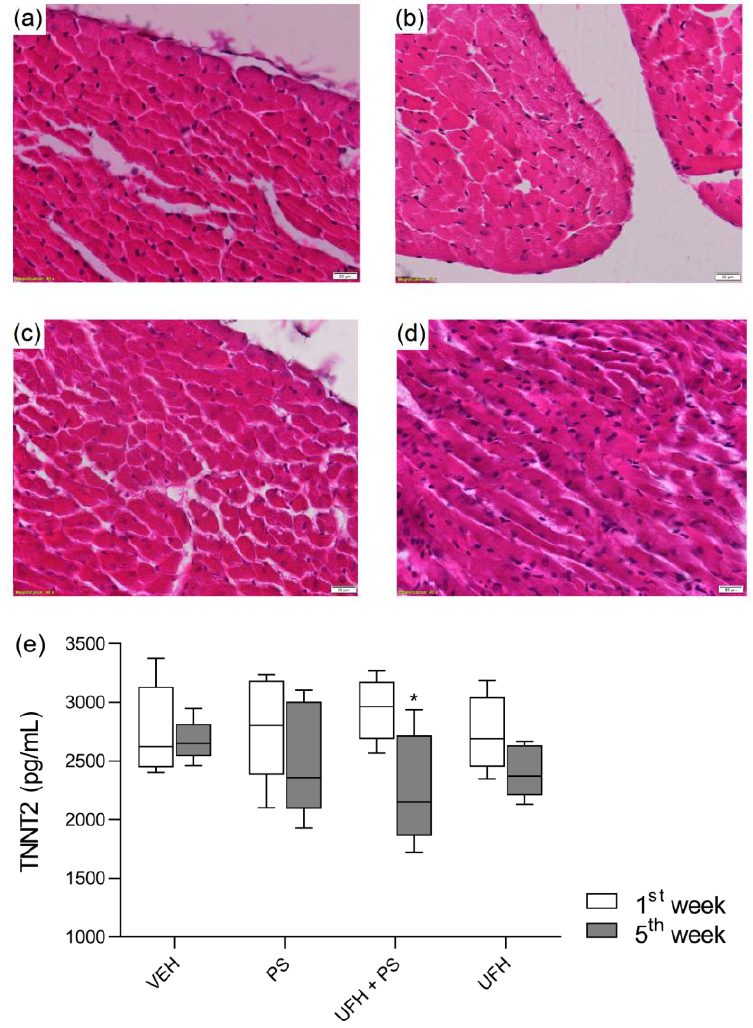
Figure 13. Histopathology of the heart tissue samples from mice treated five times with vehicle (VEH, 1 mL/kg) ( a ), protamine sulfate alone (PS, 1.5 mg/kg, 1 mL/kg) ( b ), or with unfractionated heparin (UFH, 1.5 U/kg, 1 mL/kg) ( c ) and only UFH (1.5 U/kg, 1 mL/kg) ( d ). The concentrations of cardiac troponin T type 2 (TNNT2) in mice serum in the first week after a single administration and in the 5th week after four administrations of drugs ( e ). The results are shown as the medians (line) with the interquartile ranges (box), along with maximum and minimum values (whiskers). Note: * p < 0.05 vs. VEH within the group, Kruskal–Wallis ANOVA with Dunn’s post–hoc test, n = 6–8.